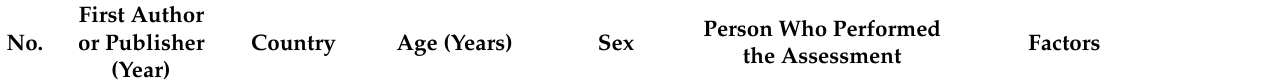
Table 1. The characteristics of the included